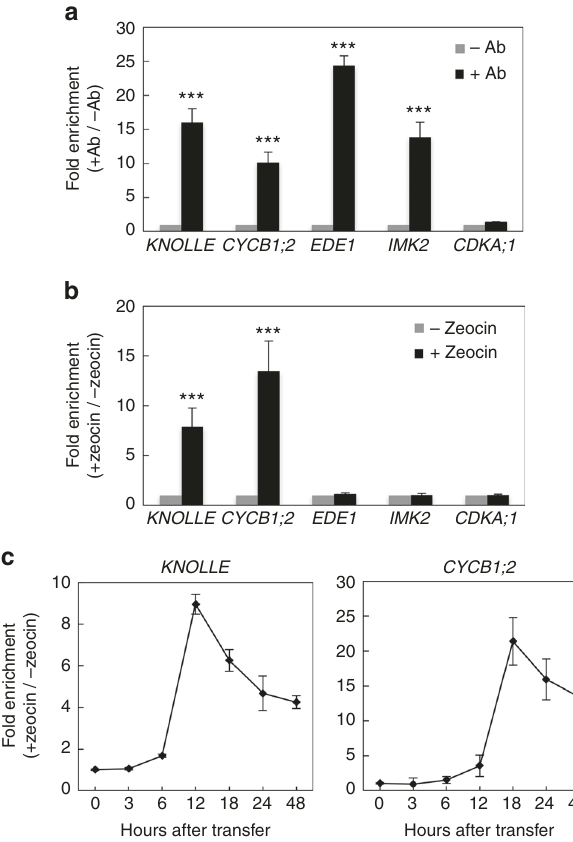
Fig. 7 DNA damage promotes the binding of MYB3R3 to KNOLLE and CYCB1;2 promoters. a ChIP-PCR analysis of G2/M-speci fi c genes. Chromatin bound to MYB3R3 was collected by immunoprecipitation with (+Ab) or without ( − Ab) anti-GFP antibodies using roots of 10-day-old myb3r3 plants carrying ProMYB3R3::MYB3R3-GFP . Fold enrichment of each promoter region was determined by normalizing the recovery rate against that of samples immunoprecipitated without the antibody . CDKA;1 was used as a control that is expressed throughout the cell cycle. Data are presented as mean ± SD of three biological replicates. Signi fi cant differences from the control immunoprecipitated without the antibody were determined by Student ’ s t -test: *** P < 0.001. b , c ChIP-PCR analysis using zeocin-treated